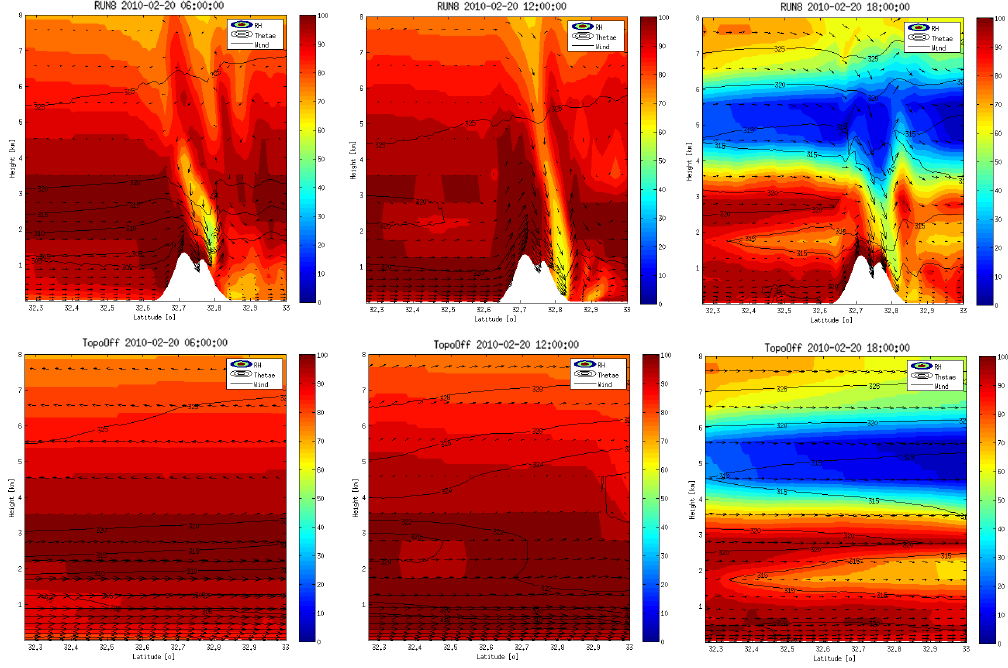
Fig. 10. Vertical Cross Sections of equivalent potential temperature (K), relative humidity (%) and wind vectors ( v and w components ms − 1 ).